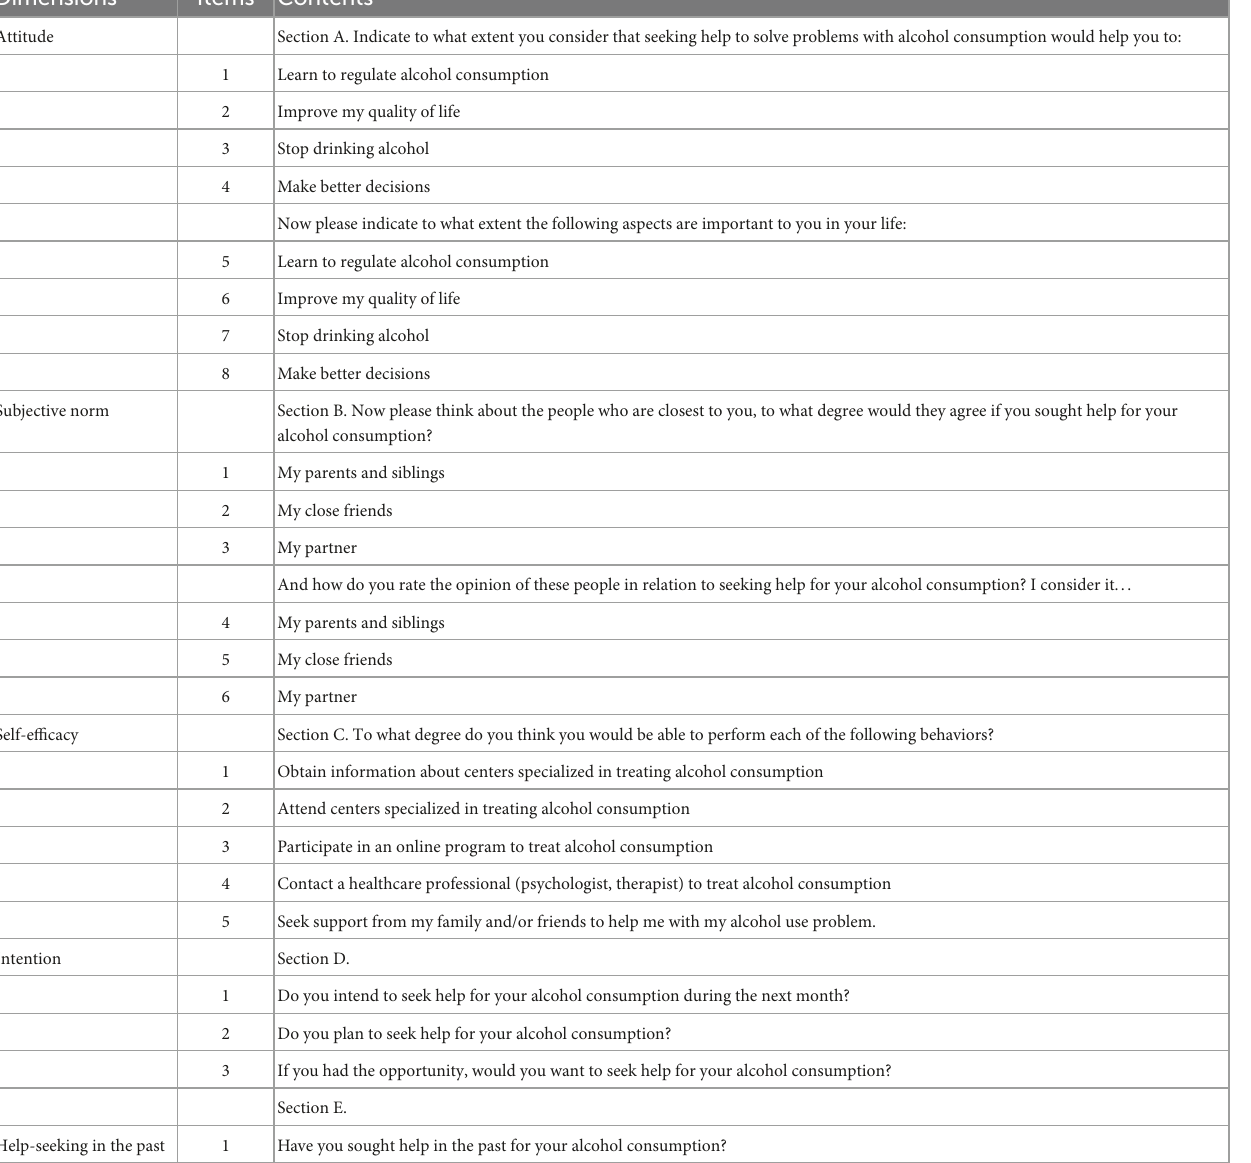
TABLE 1 Dimensions and items of the IH-RHAC